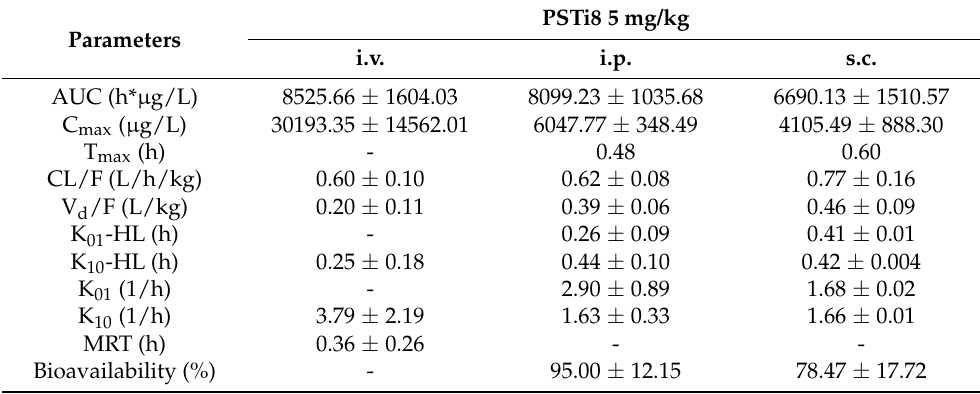
Table 2. Pharmacokinetic parameters of the PSTi8 peptide after i.v., i.p. and s.c. administration at 5 mg/kg in male SD rats. Data are presented as the mean ± SD with n =